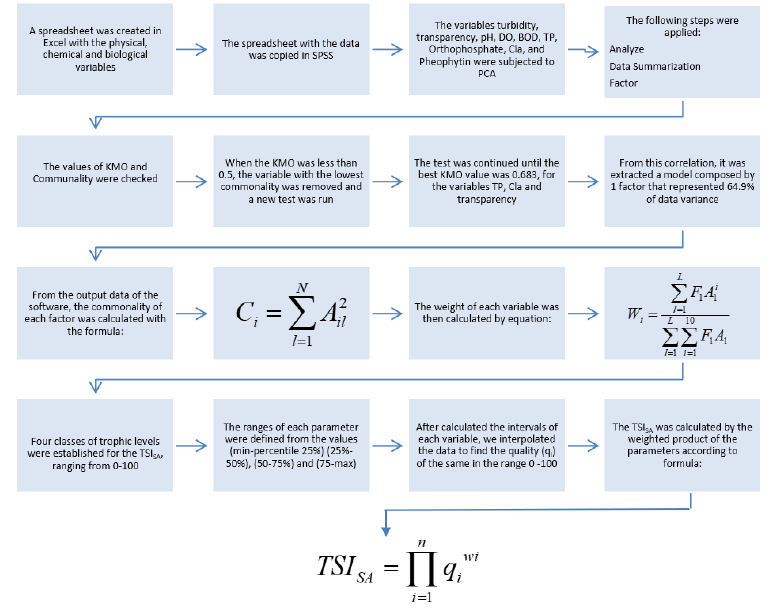
Figure 3. Process flowchart for obtaining the TSI